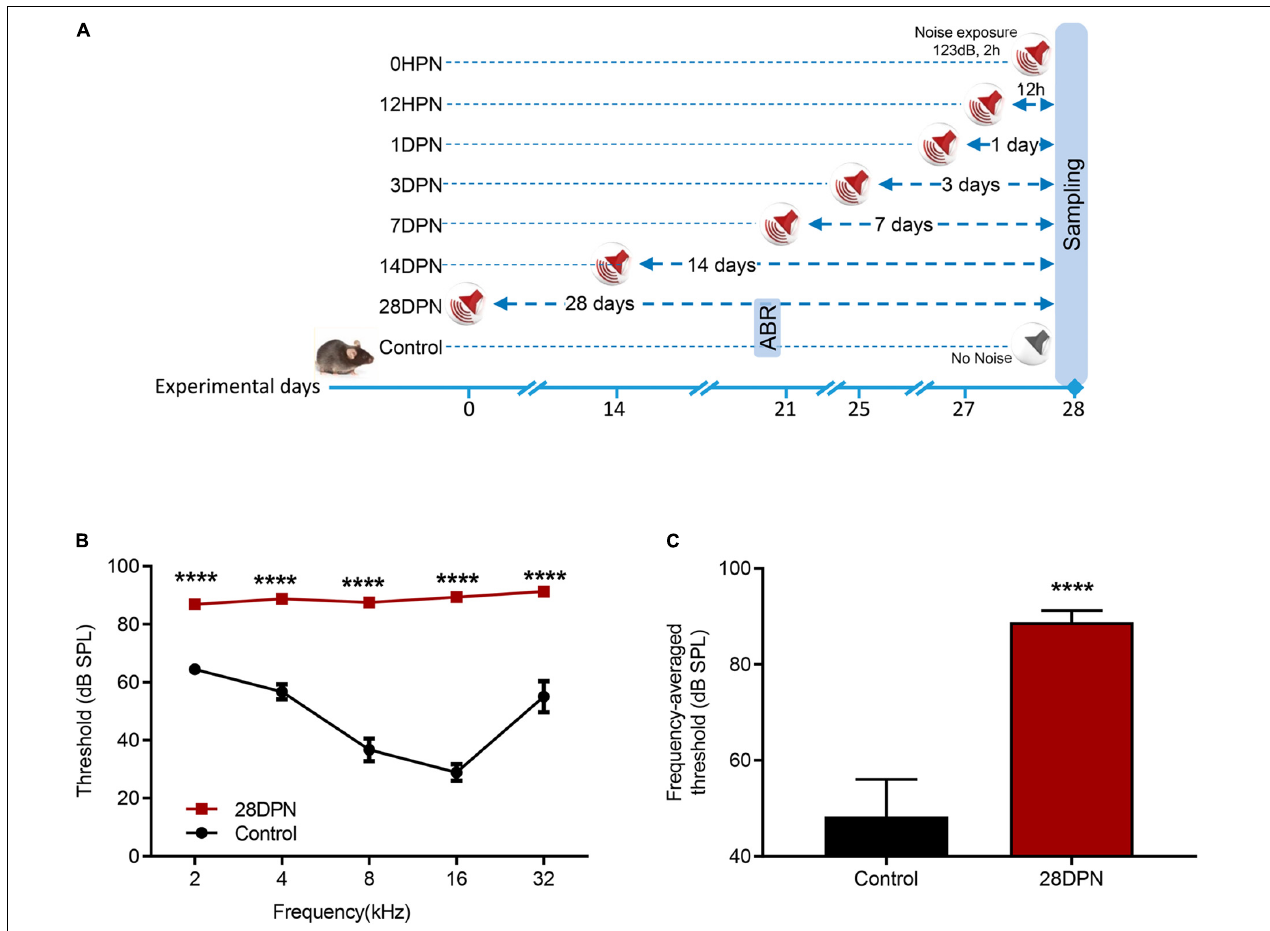
FIGURE 1 | Noise-induced ABR threshold shift measured at 20 days post noise exposure. (A) Experimental design for noise exposure and sampling. (B) ABR frequency-threshold curves of the 28DPN and control groups obtained at 20 days after noise exposure. (C) ABR frequency-averaged thresholds for the 28DPN and control groups obtained at 20 days after noise exposure. The values are presented as the mean ± SEM of eight mice per group. **** p < 0.0001 in the post hoc comparisons between the 28DPN group and the control group using two-way repeated-measure ANOVA (B) or t -test (C)